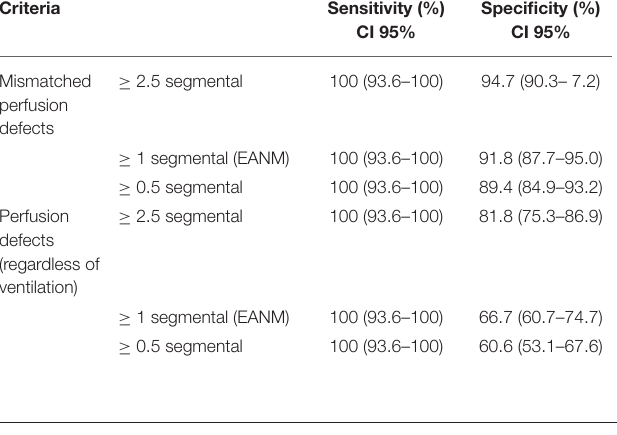
TABLE 2 | Sensitivity and specificity according to criteria tested.